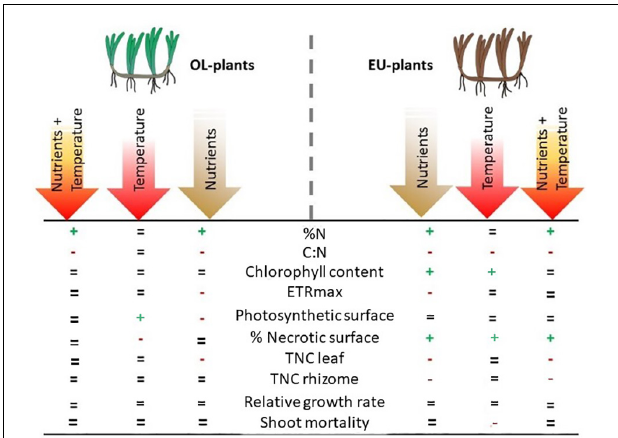
FIGURE 6 | Summary of the overall physiological responses of P. oceanica from oligotrophic (OL) and eutrophic (EU) environments to nutrient excess, temperature increase and their combination. Signs ( + , − , = ) reflect statistical significance and direction of the difference in respect to the